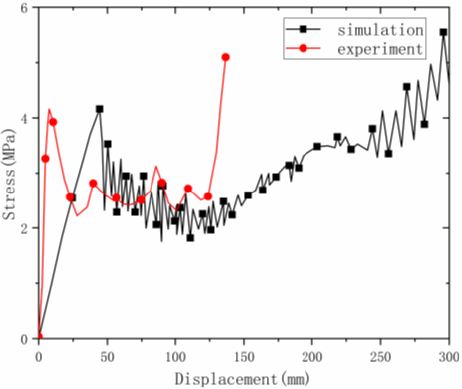
Figure 20. Comparison of simulation and test curves under axial loading.